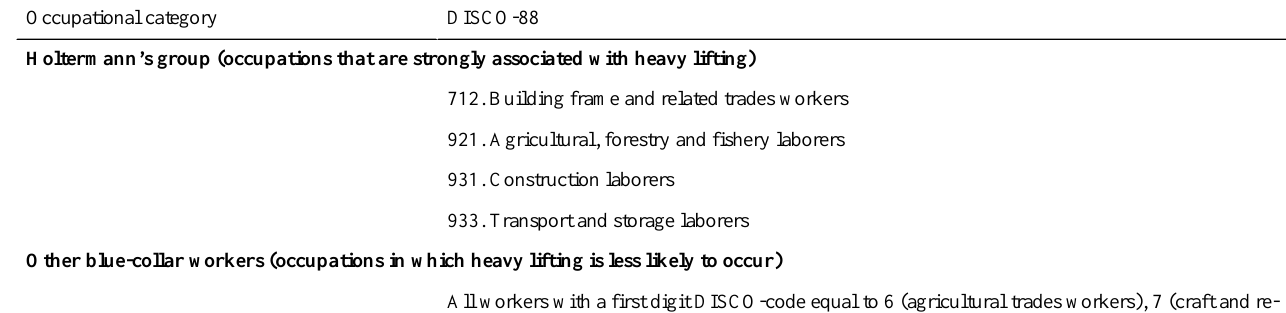
Table 1. Occupational categories according to DISCO-88.